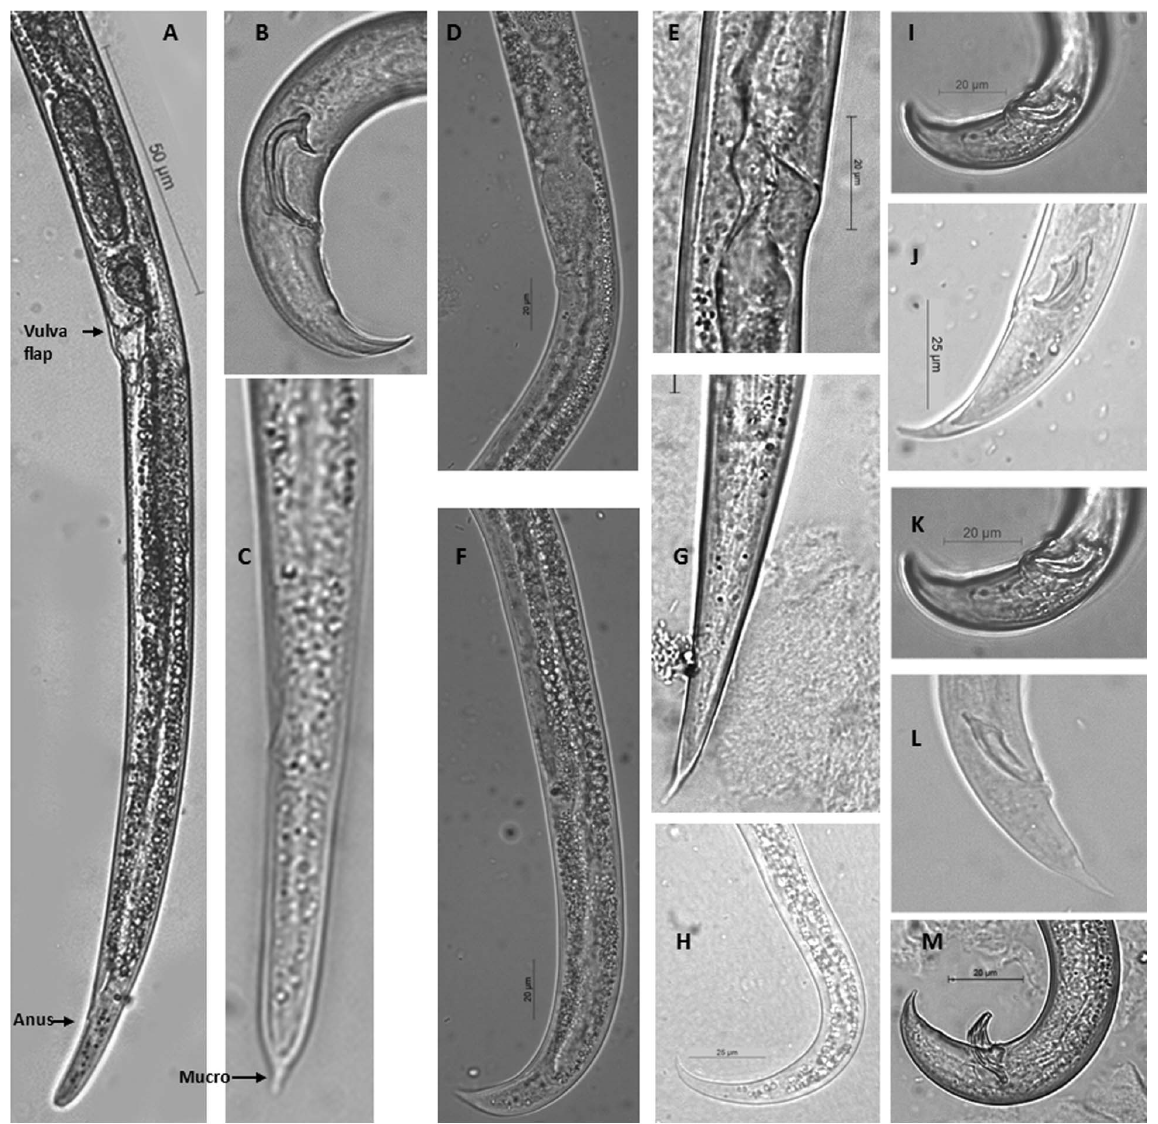
Figure 3. Morphological comparisons between Bursaphelenchusxylophilus (A-C) and other wood-inhabiting aphelenchids (D-M). A. Posterior female end showing vulva flap, anus and blunt tail. B. Male spicule and tail end. C. Female tail showing mucro. D-E. Vulva without flap. F-H. Female pointed tail. I-M. Spicule and tail end of male.